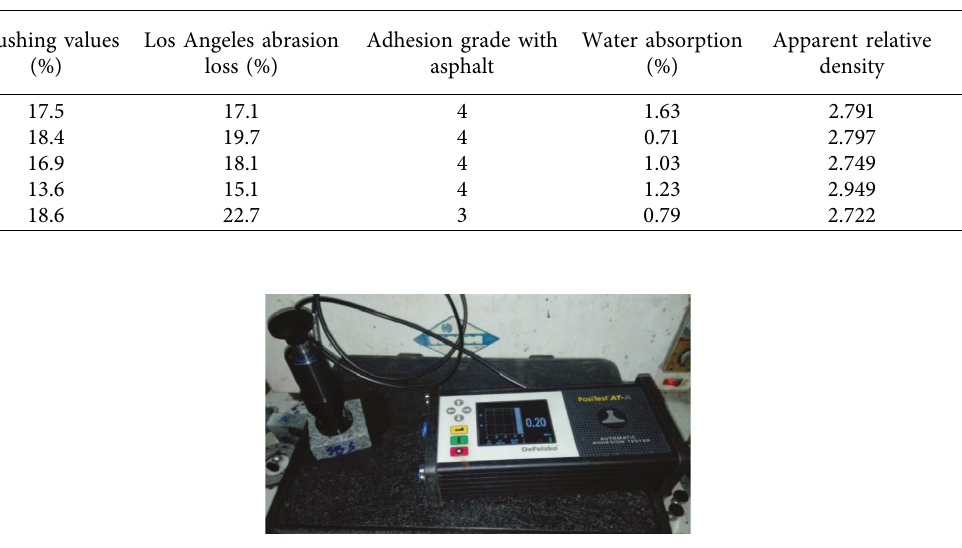
Table 4: Technical index of test stone.